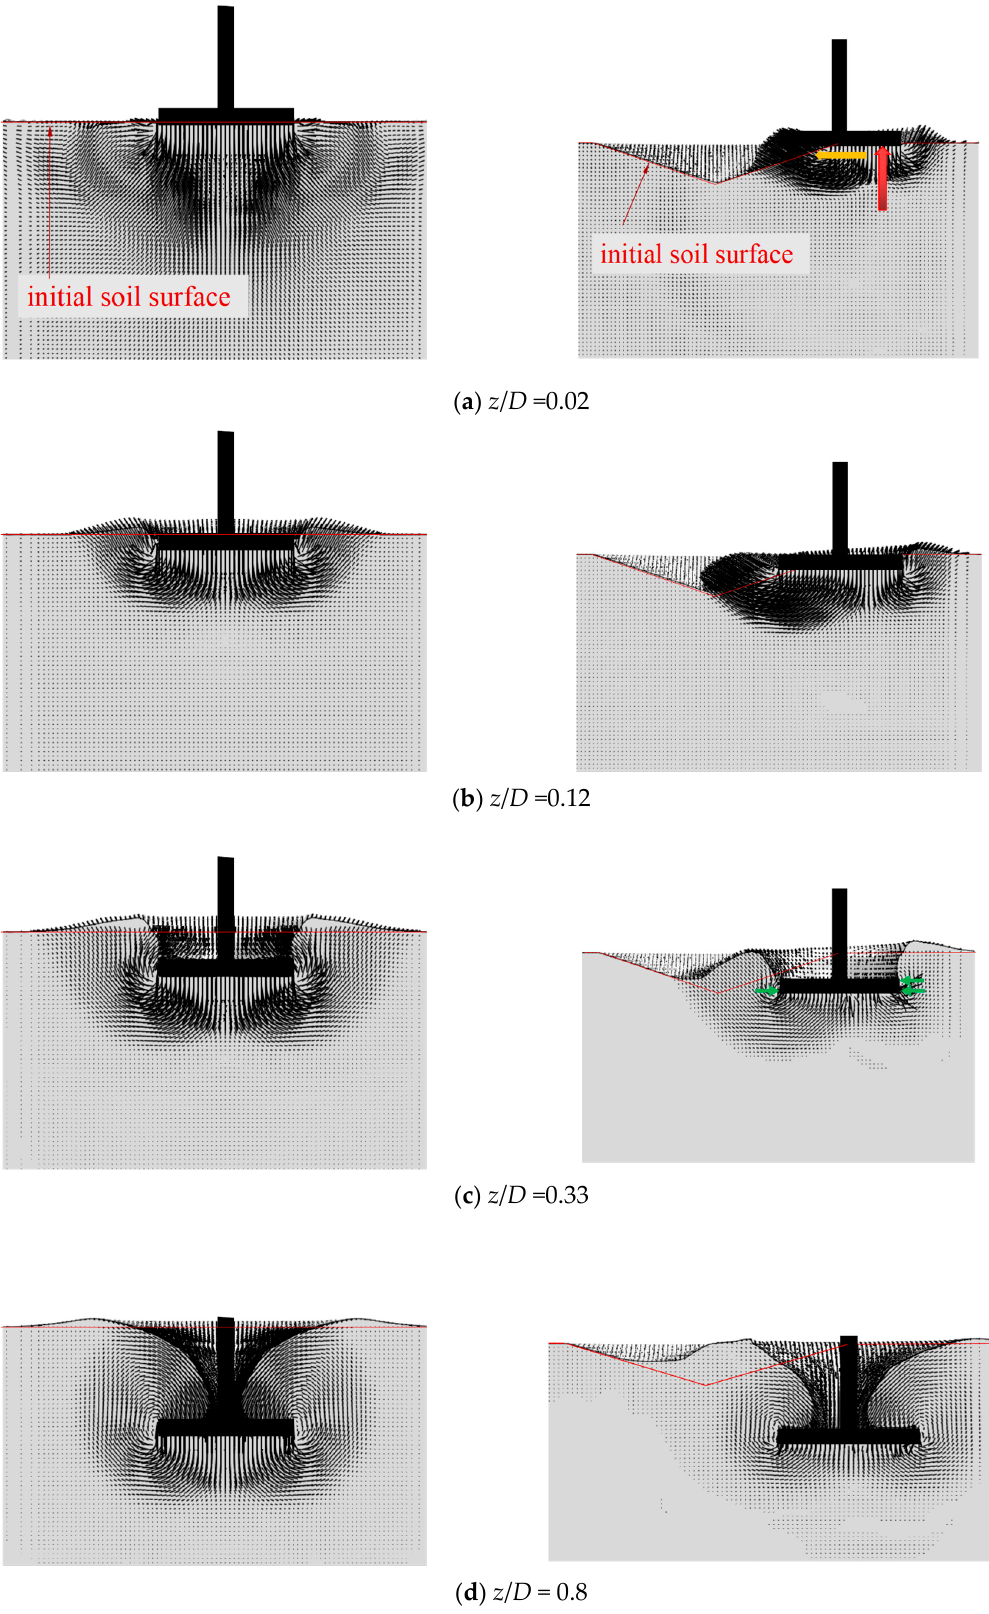
Figure 8. Soil flow mechanism of cases FS ( left ) and TB-2 D -1.0 D ( right ) for flat base footing.